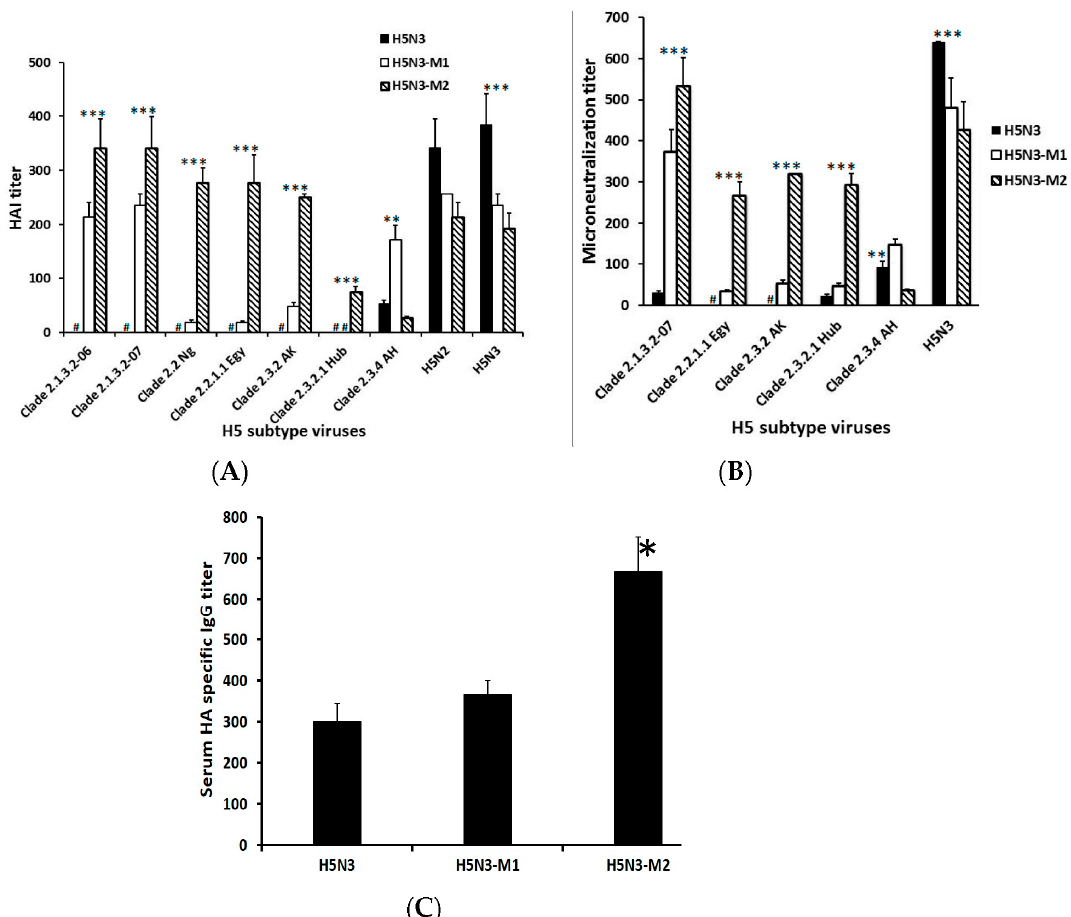
Figure 2. Measurement of systemic immune responses of vaccinated mice sera: Mice subcutaneously immunized on days 0 and 28 with RG-H5N3 or RG-H5N3HA M1 or RG-H5N3HA M2 viral vaccine. ( A ) Serum hemagglutination inhibition (HAI) assay. The serum HAI on day 49 against H5N1 viruses